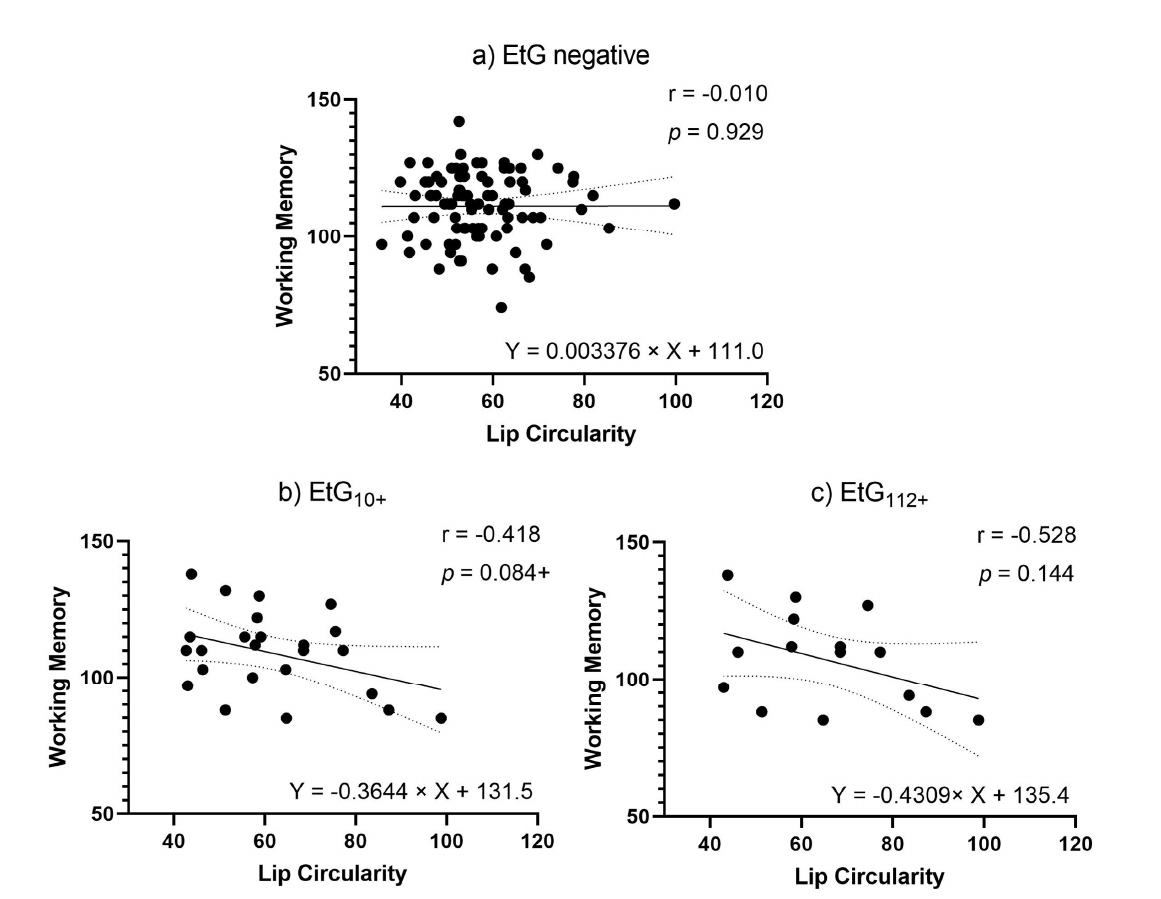
Figure 5. ( a ) Lip circularity versus working memory for EtG-negative individuals (the 10 ng/g cut-off, EtG-negative n = 97). ( b ) Lip circularity versus fluid reasoning for EtG10+ individuals (EtG 10 + n = 32). ( c ) Lip circularity versus working memory for EtG112+ (EtG 112 + n = 20) cut-offs. Higher lip circularity value = smaller upper lip size. + p <